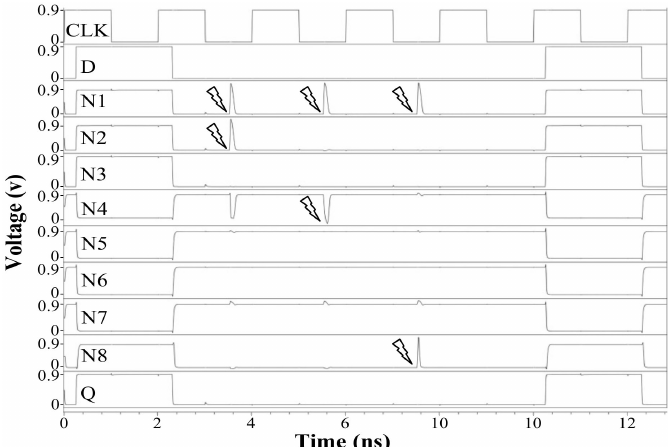
Figure 12. Simulation for DNU injections of HTNURL